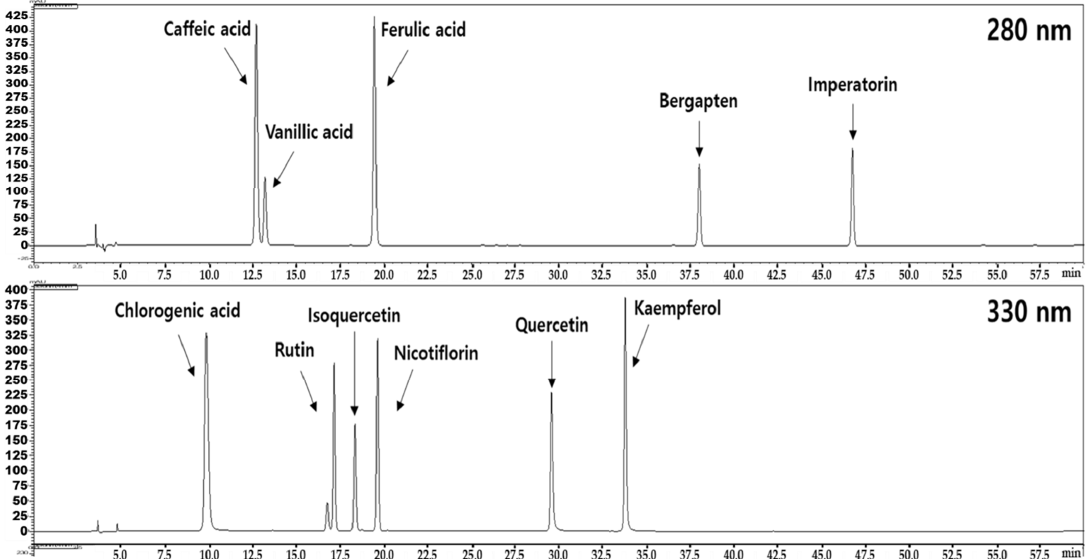
Figure 4. HPLC chromatograms of phenolic acids (chlorogenic acid, r 2 = 0.9999; ferulic acid, r 2 = 1; caffeic acid, r 2 = 1; and vanillic acid, r 2 = 1), flavonoids (rutin, r 2 = 0.9999; isoquercetin, r 2 = 0.9999; nicotiflorin, r 2 = 0.9999; quercetin, r 2 = 0.9998; and kaempferol, r 2 = 0.9999), and coumarins (bergapten, r 2 = 1 and imperatorin, r 2 = 1) in the ethanolic extract of G. littoralis .